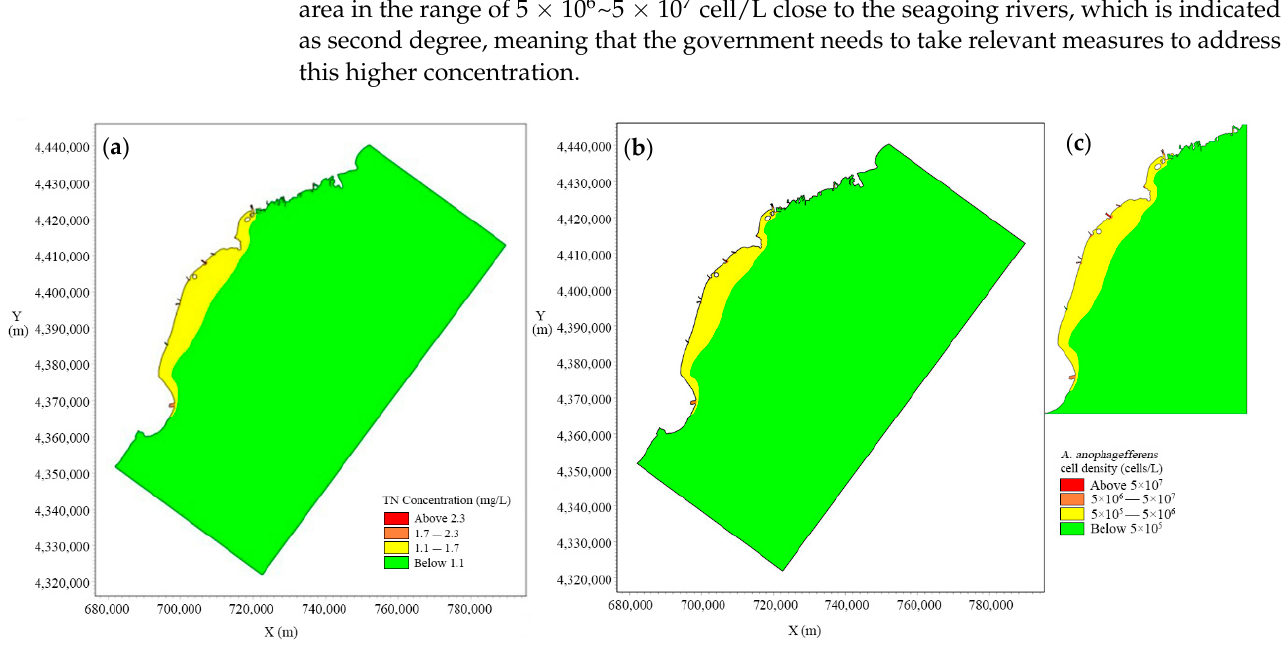
Table 5. The brown tide warning and fast forecast monitoring indicator of A. anophagefferens density. A. anophagefferens Density (Cells/L)